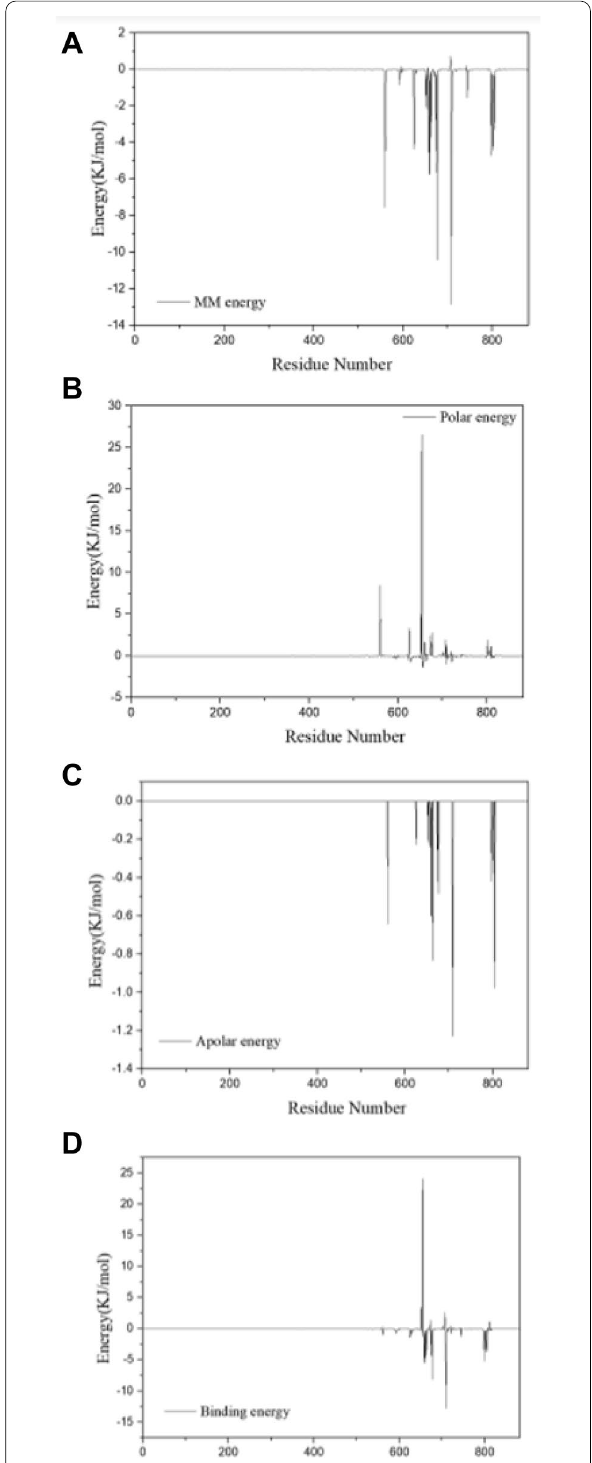
Fig. 12 Residual energy contribution analysis of receptor–ligand